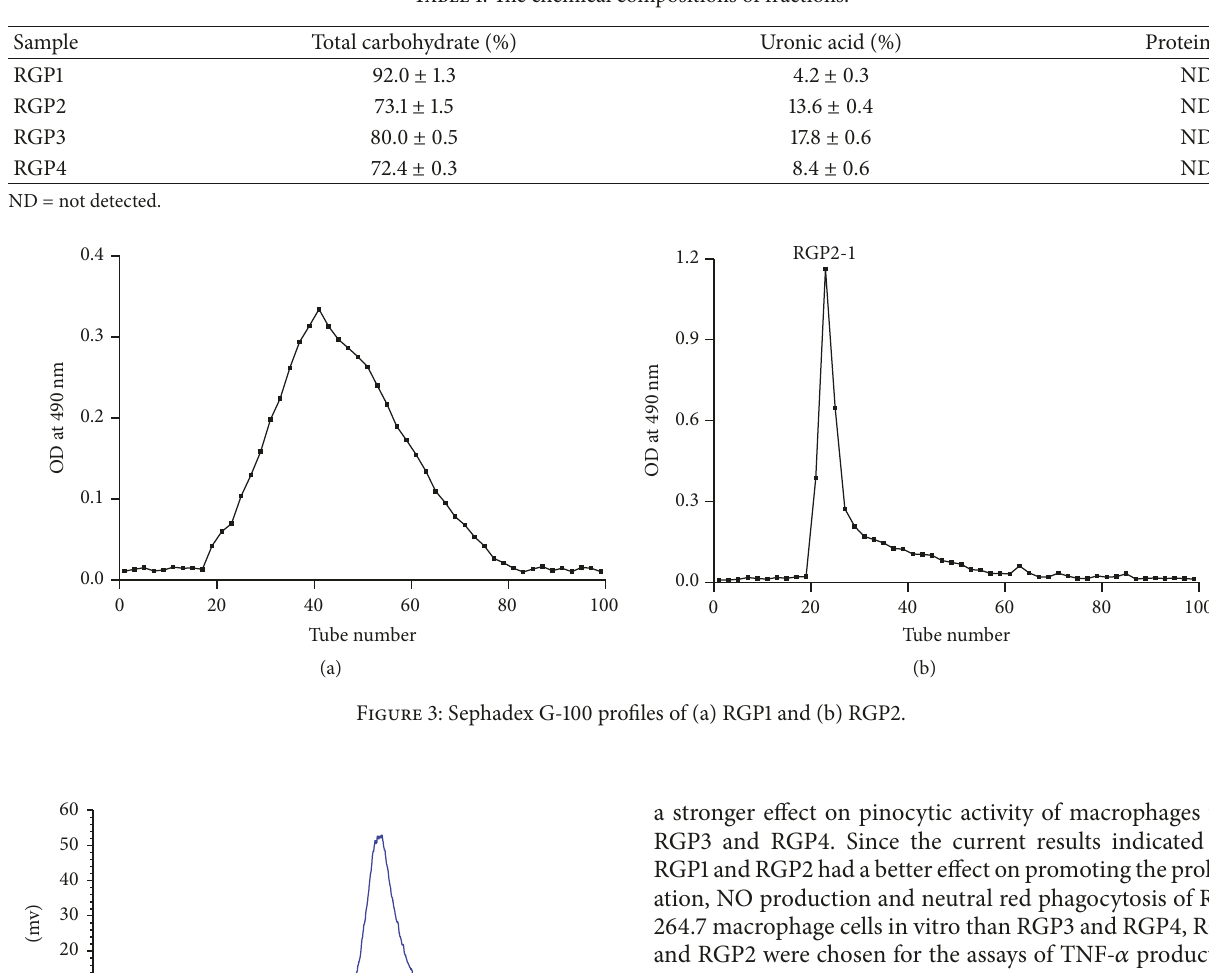
Table 1: The chemical compositions of fractions.